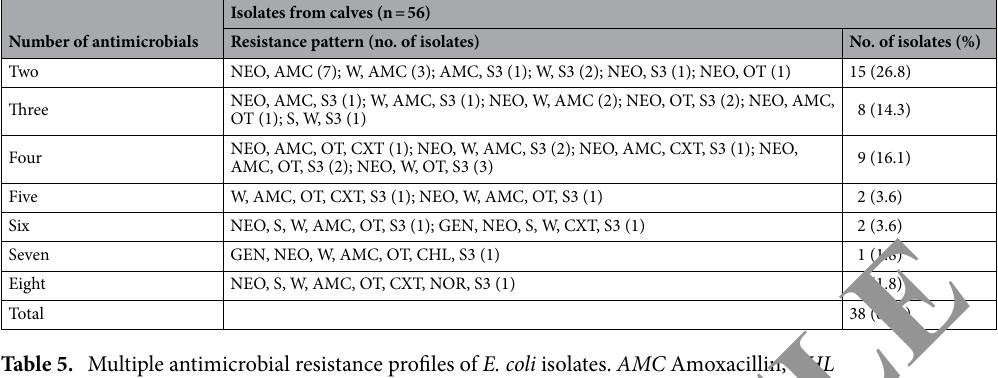
Table 5. Multiple antimicrobial resistance profiles of E. coli isolates. AMC Amoxacillin, CHL Chloramphenicol, CPR Ciprofloxacillin, CXT Cefoxitin, GEN Gentamycin, NEO Neomycin, NOR Norfloxacillin, OT Oxytetracycliine, S Streptomycin, S3 Sulfonamides, W Trimethoprim.